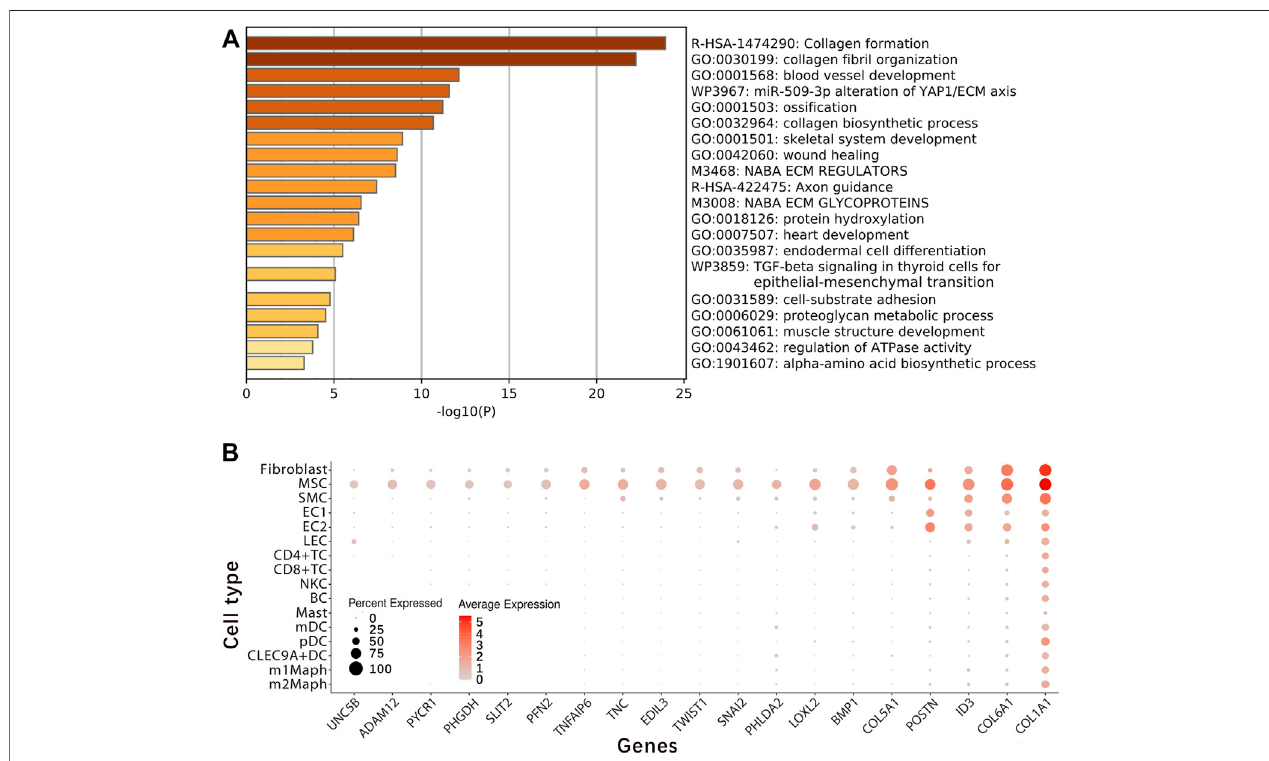
FIGURE 2 | Identi fi cation of embryonic mesenchymal stem cells. Differential expression analysis between cells inside and outside fi broblast2 was performed to generate a gene-expression signature ( Supplementary File S2 ). From the gene-expression signature, the 63 coding genes and a long noncoding RNA (lncRNA) gene RP11-14N7.2 ( Table 2 ) were selected for the exact identi fi cation of fi broblast2. Finally, we concluded that fi broblast2 is a cluster of embryonic mesenchymal stem cells (MSCs). (A) . GO and pathway annotation of the 63 coding genes with analysis were performed using the Metascape website; (B) . At least 19 genes ( UNC5B , ADAM12 , PYCR1 , PHGDH , SLIT2 , PFN2 , TNFAIP6 , TNC , EDIL3 , TWIST1 , SNAI2 , PHLDA2 , LOXL2 , BMP1 , COL5A1 , POSTN , ID3 , COL6A1 , and COL1A1 ) havebeen reported to be over-expressed or up-regulated in stem cells, and among these 19genes, seven ( PYCR1 , TNFAIP6 , EDIL3 , TWIST1 , LOXL2 , BMP1 , and COL1A1 ) have been reported to be expressed in MSCs in the previous studies ( Supplementary File S3